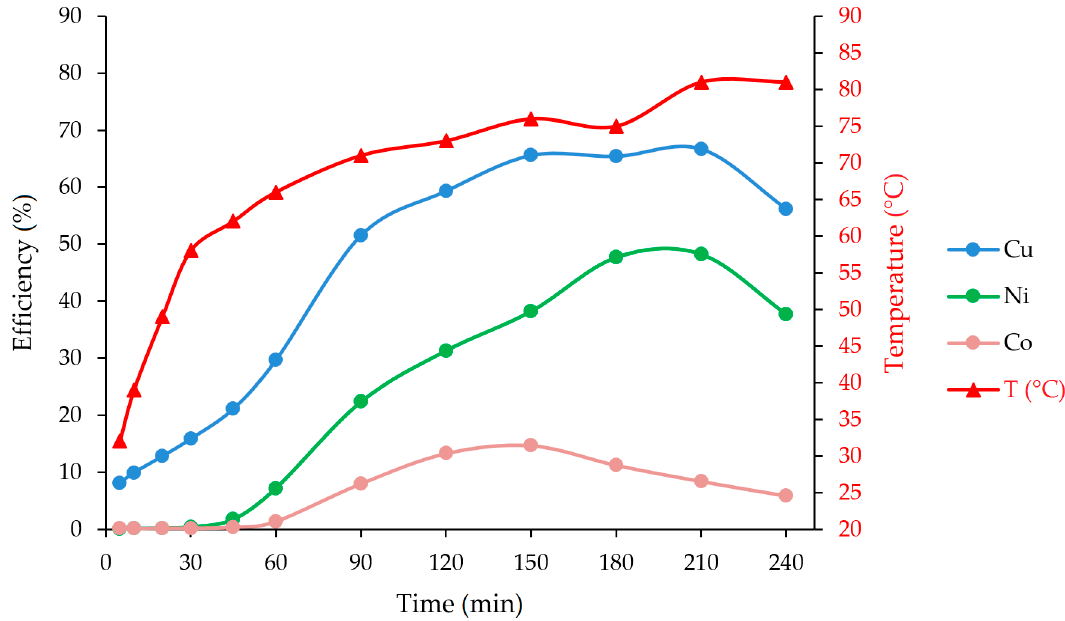
Figure 8. Kinetics of metals extraction during ammoniacal leaching with microwave (60 W).